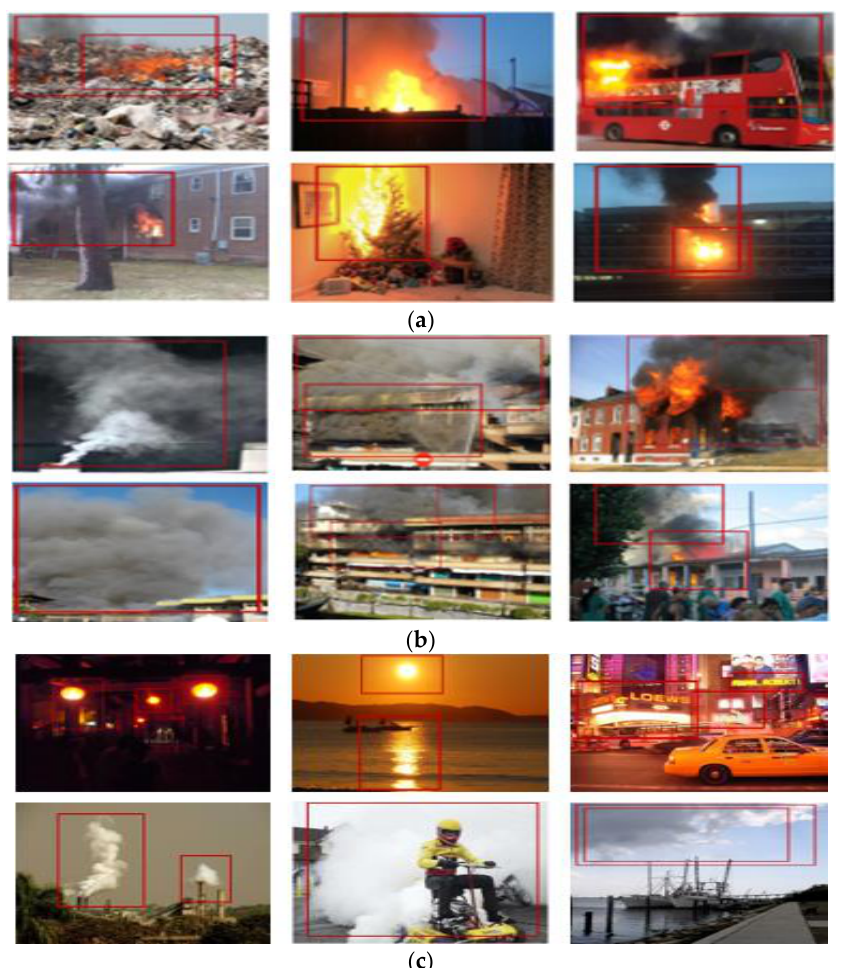
Figure 9. Results of Faster R-CNN fire detection, ( a ) flames detection results, ( b ) smoke detection results, and ( c ) false positive detection results.